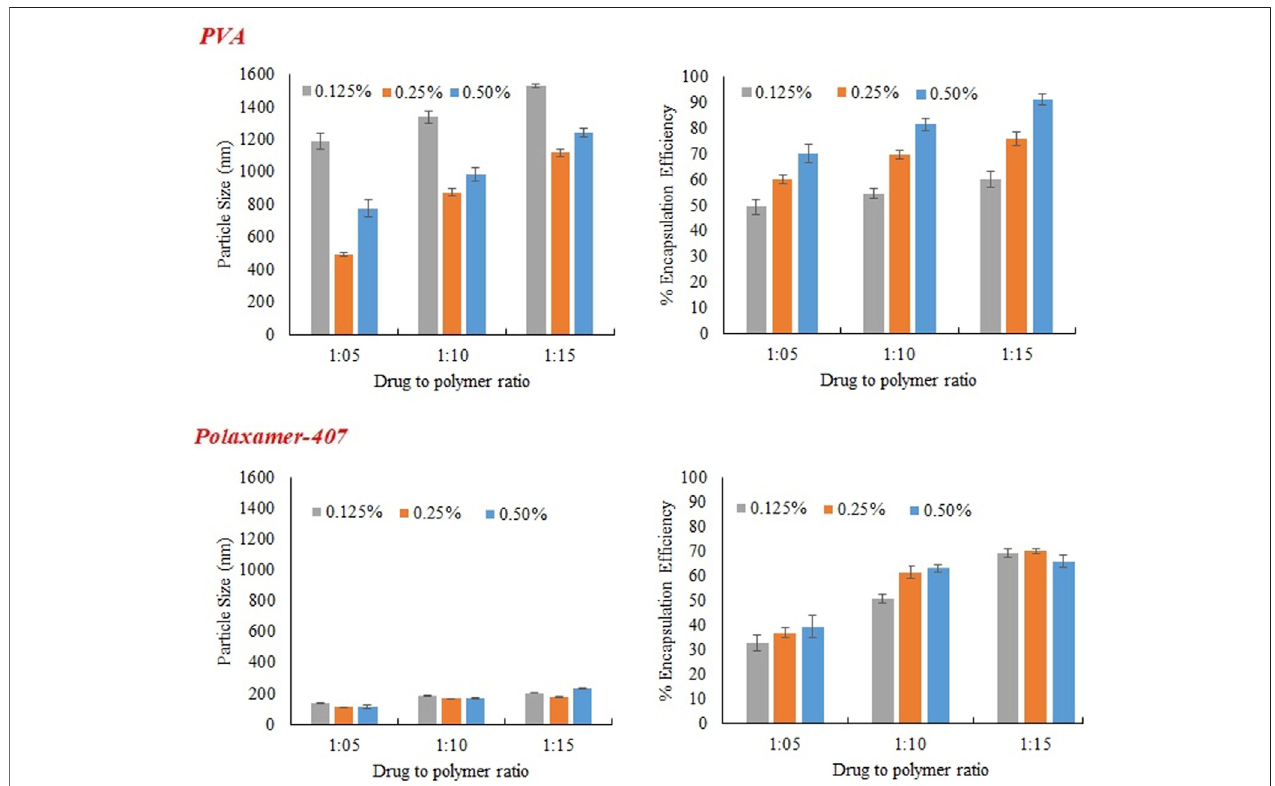
FIGURE 3 | Effect of concentration of emulsi fi er (PVA and Poloxamer-407) on particles size, and encapsulation ef fi ciency of MTX nanoparticles using Eudragit S100.